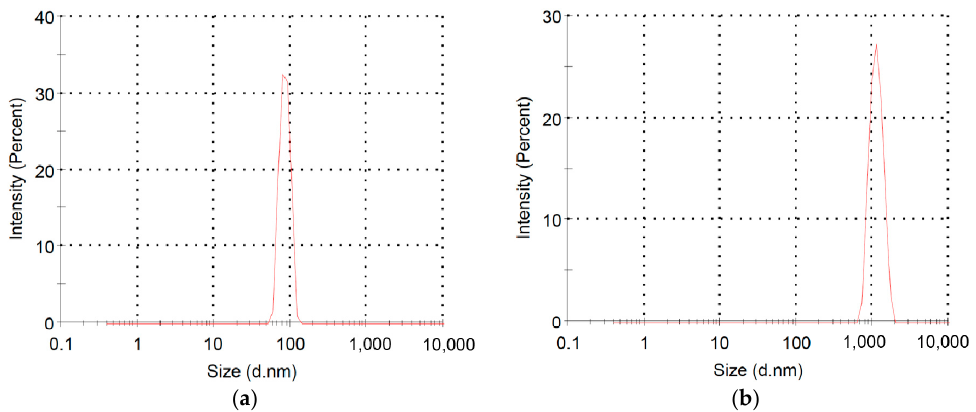
Figure 7. Size distributions of macromer P3HT-(CH 2 ) 3 -VIM ( a ) and brush polymer P[P3HT-(CH 2 ) 3 -VIM] ( b ) in CHCl 3 /MeOH ( v / v = 1/2) measured by DLS at RT.